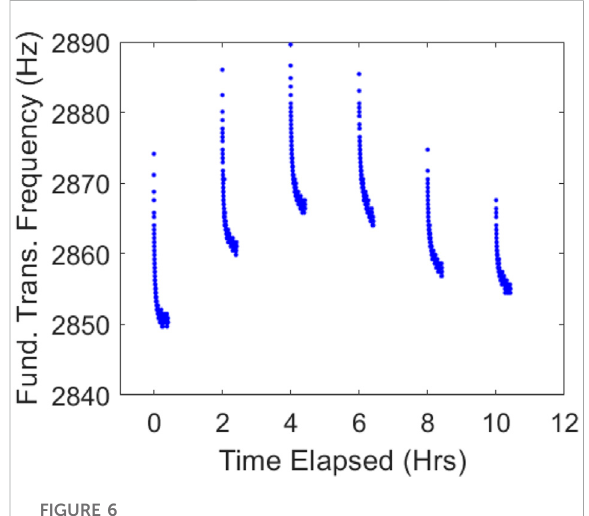
FIGURE 6 Multiple repeated sequential impact tests with intermittent restperiodsperformedona2-hrecoverycycleoncementpastein an uncontrolled laboratory